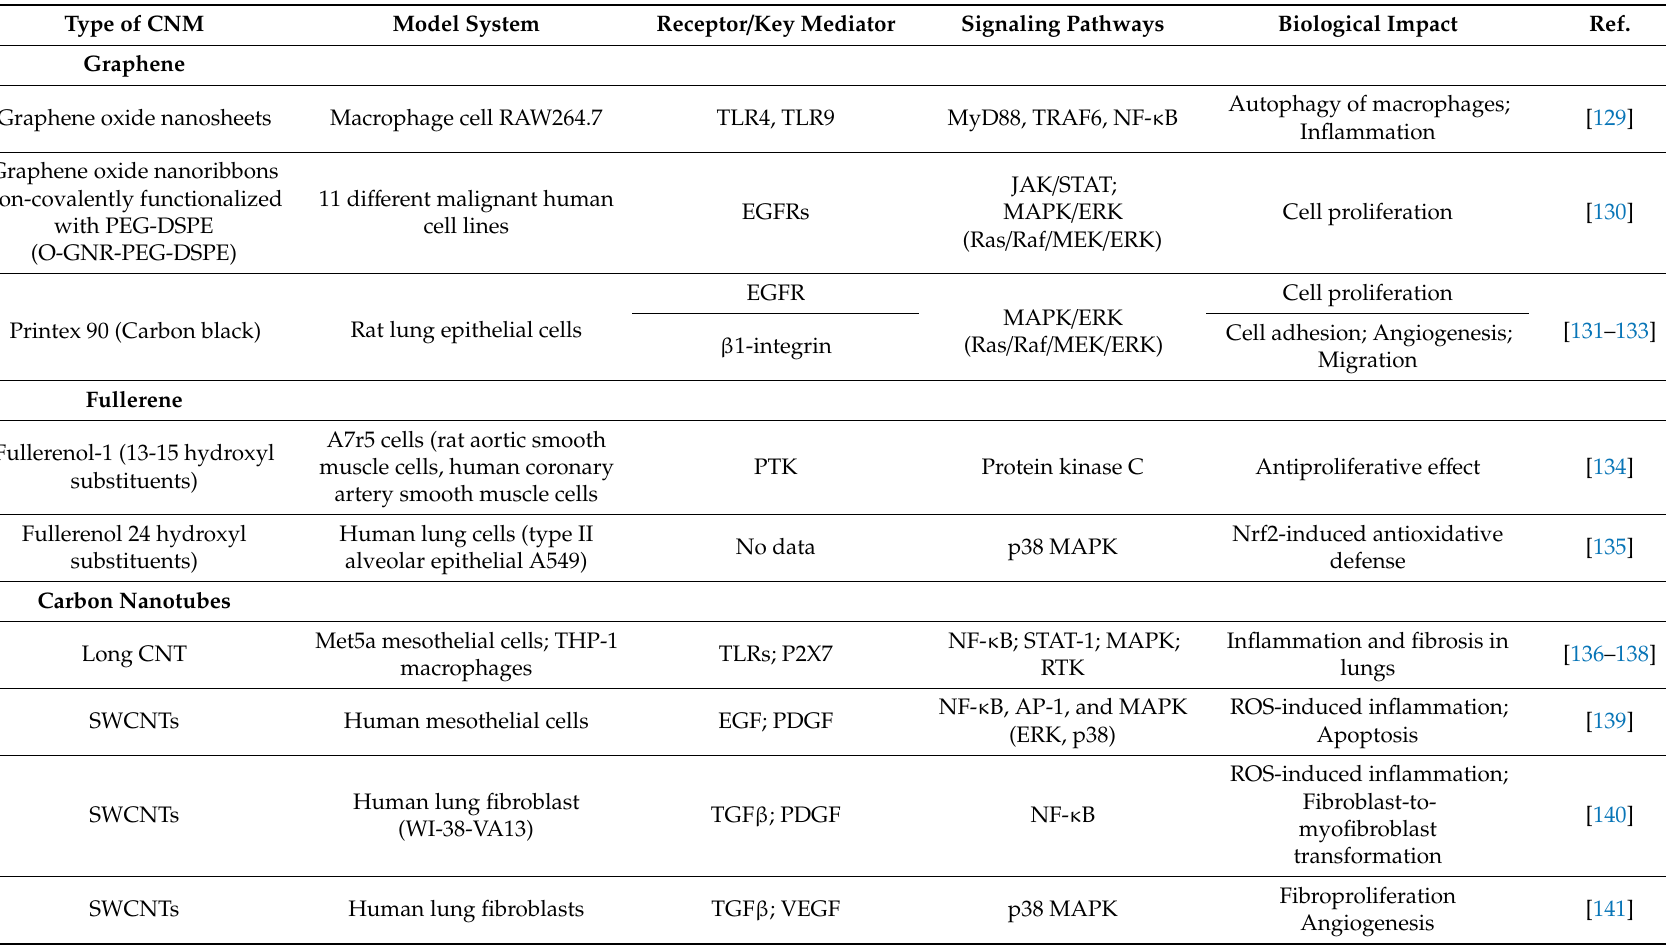
Table 2. Biological impacts caused by di ff erent carbon nanomaterials (CNMs) via various signaling